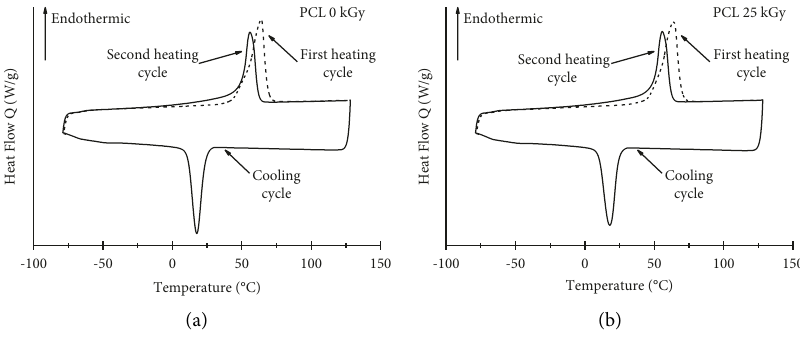
Figure 7: DSC curves of (a) 0kGy PCL and (b) 25kGy